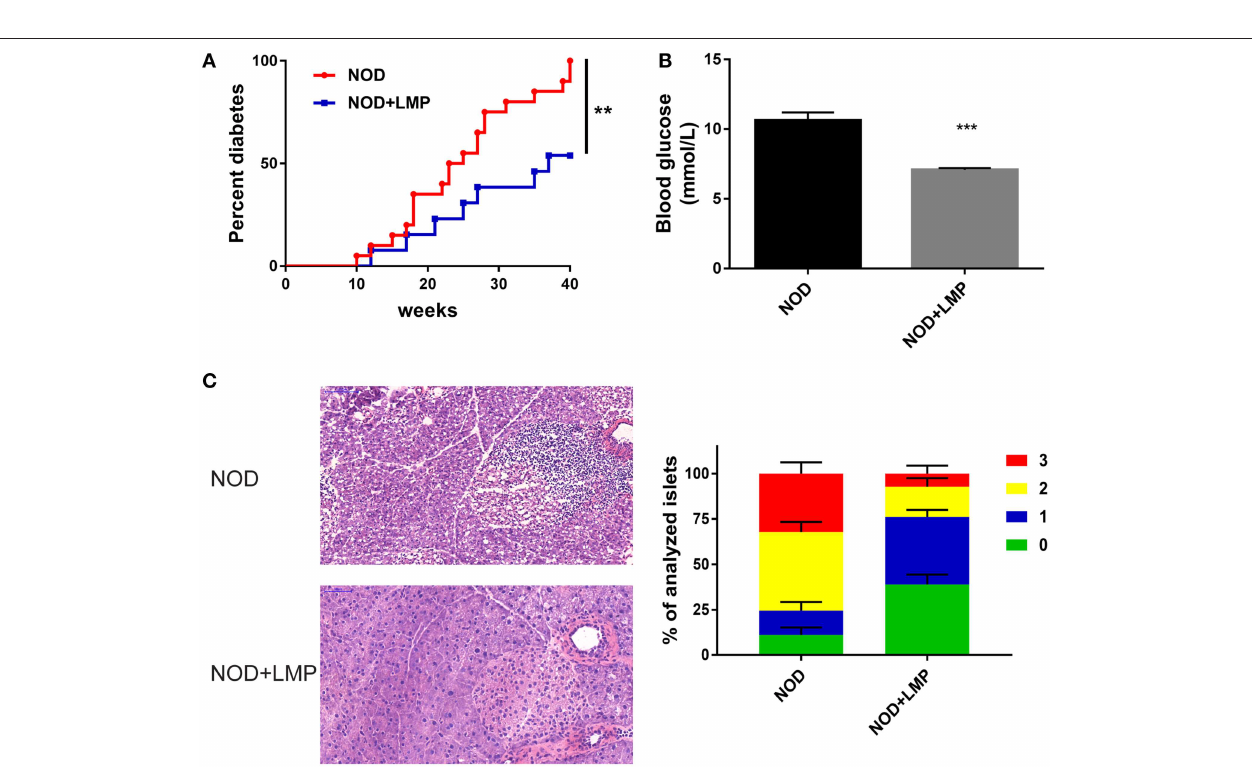
FIGURE 2 | LMP supplementation protects against T1D in NOD mice. (A) Diabetes incidence of NOD mice treated with (LMP) or without (normal chow) 5% LMP supplementation from 4 to 40 weeks of age. n = 20. (B) The fasting blood glucose of non-diabetic NOD mice at 40 weeks of age. (C) H&E staining of pancreatic islets from NOD mice at 40 weeks of age. Insulitis score was quantified. Scale bar, 100 µ M. ** p < 0.01 and *** p < 0.001.